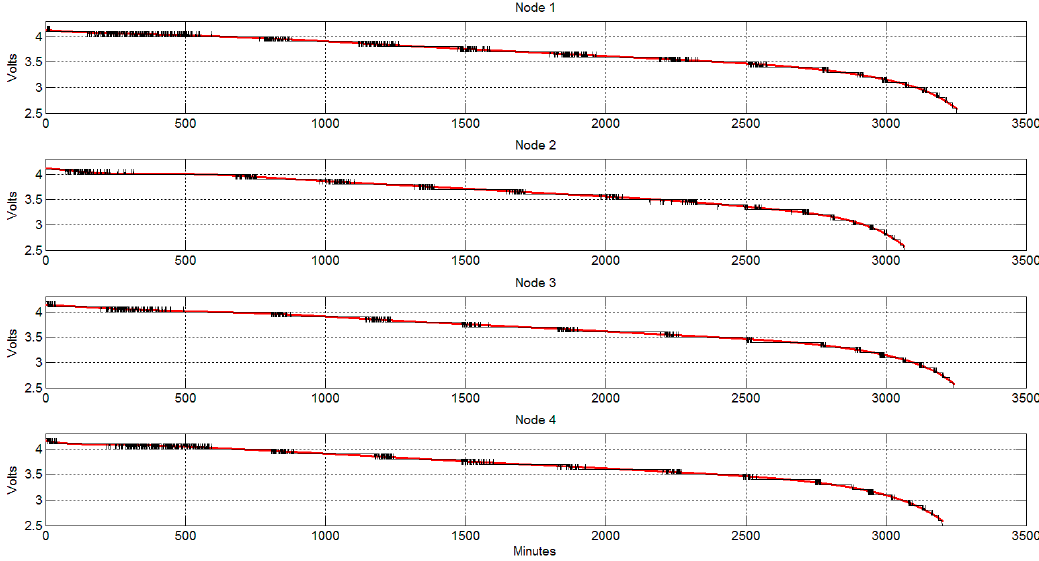
Figure 18. Energy consumption test (continuous work, full power of nodes).